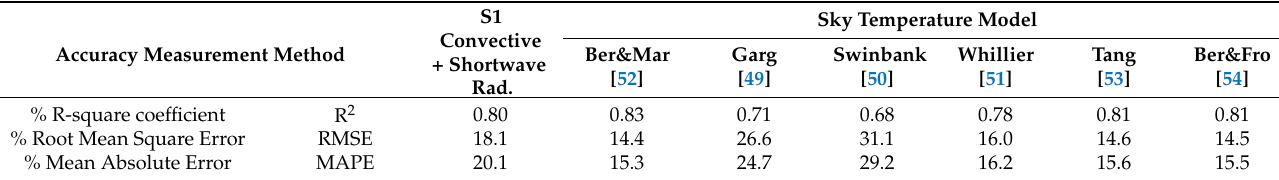
Table 6. Longwave radiation impact on S1 (exposed